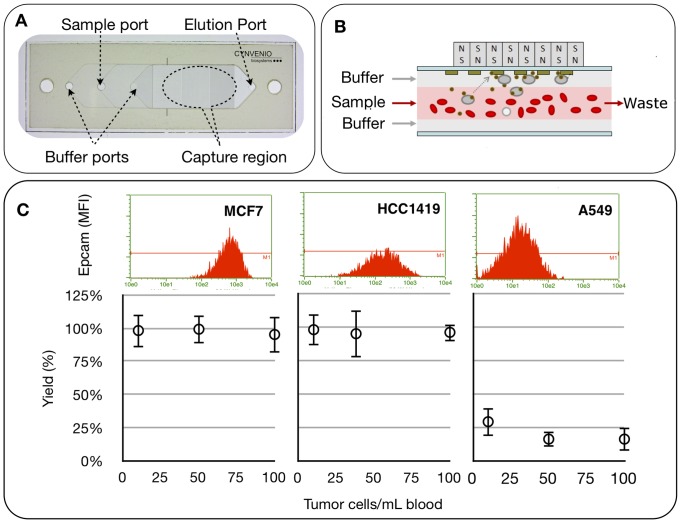
CTC Flow cell operation and performance.(A) The LiquidBiopsy CTC flow cell. (B) A cartoon illustrating how target cells are pulled from the sheath flow while non targets move through the flow cell unhindered. (C) Efficiency of recovery of target cells using EpCAM based recovery: Incremental numbers of MCF7 (N = 34), HCC1419 (N = 27) or A549 (N = 65) cells were spiked into NHD blood and purified on the CTC flow cell. Recovered cells were enumerated in the flow cell. Graphs show number of targets spiked per mL of blood against the yield +/−1 SD from an average of between 7 and 27 experiments.